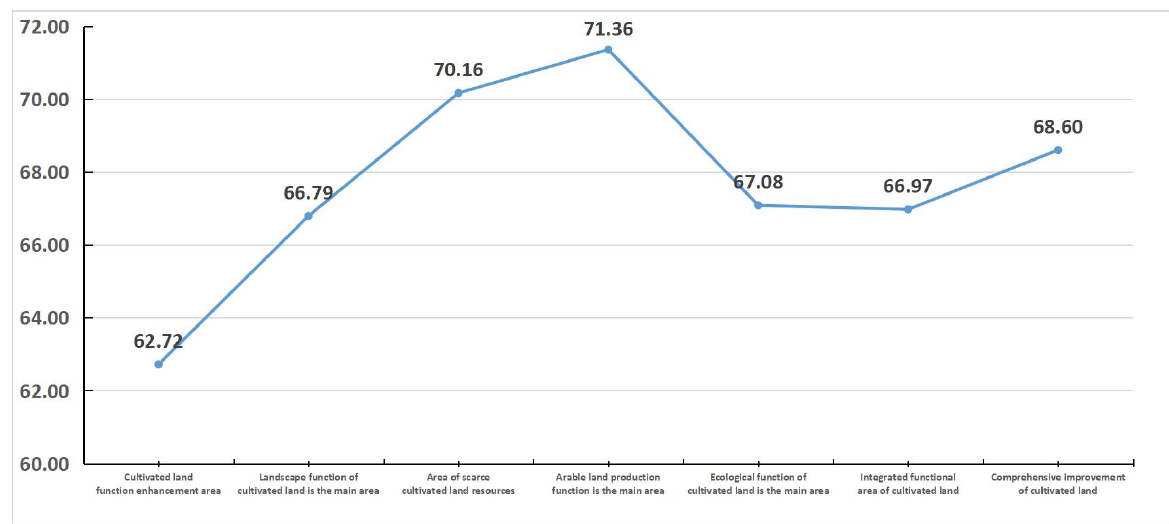
Figure 8. Comprehensive quality of cultivated land in various types of districts in Qujiang District.